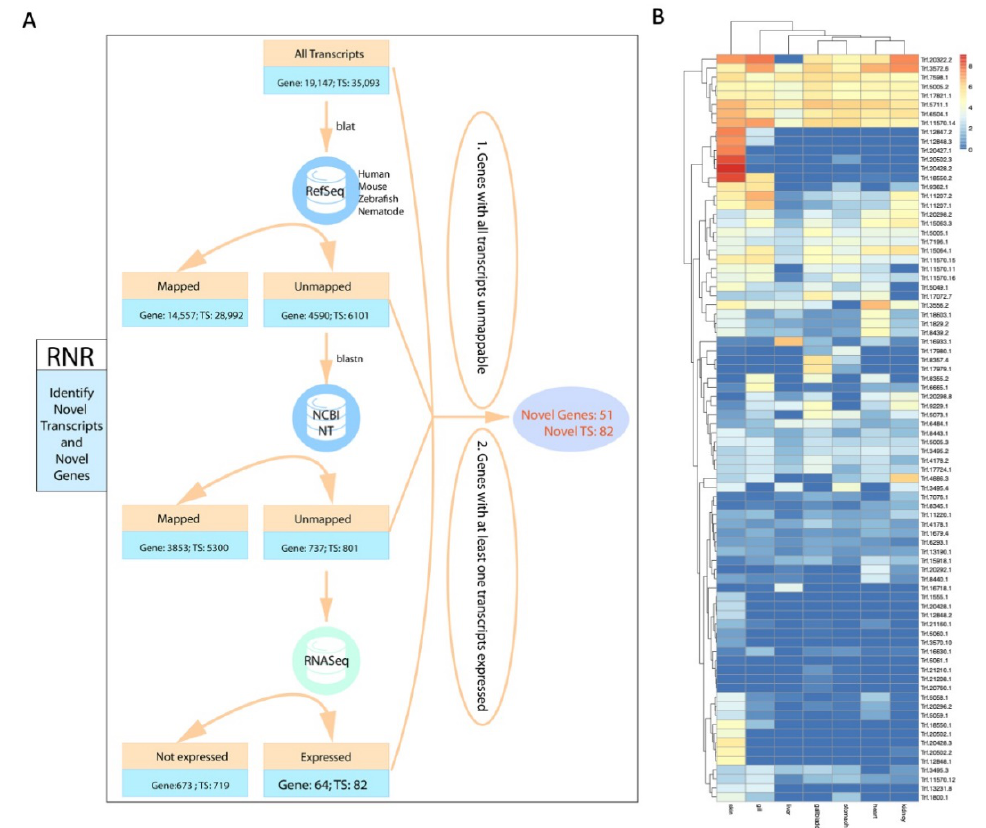
Figure 5. Identification of novel genes and transcripts. ( A ) Flowchart of RNR novel gene/transcript identification method. ( B ) Heatmap of the expression (log1p(FPKM)) of the novel transcripts in seven tissues.